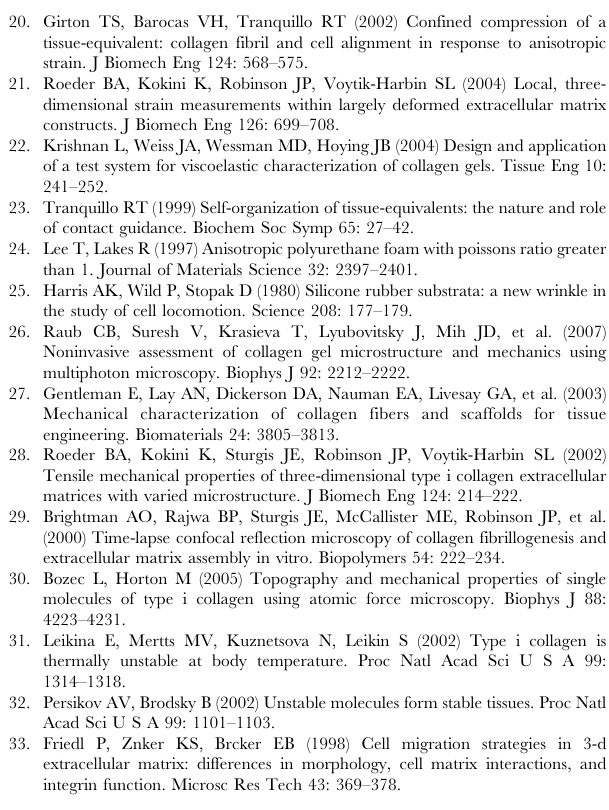
Figure 7. Characterization of the reversibility of alignment and densification in crosslinked and uncrosslinked collagen samples. Response to cycles of deformation for untreated collagen gels (A–E) and gels treated with glutaraldehyde (F–K). (A) Histograms of the fiber orientation as a function of the imposed strain for untreated sample; color at each point corresponds to the relative count of fibers oriented along a specific direction at a given strain e xx . (B) Resulting order parameter for untreated sample. (C–E) Confocal reflectance images of a 1 mg/mL collagen sample cycled 4 times up to 15% stretch and back to 0%, showing the extent of the reversibility at the microstructural level: (C) beginning of 1st stretch cycle; (D) middle of 1st stretch cycle; (E) end of 1st stretch cycle; bars=50 m m. (F) Histograms of the fiber orientation as a function of imposed strain for glutaraldehyde-treated sample; color-coding as in (A). (G) Resulting order parameter and density for glutaraldehyde-treated sample. (H–J) Confocal images of a 1 mg/mL collagen samples with glutaraldehyde, cycled 4 times up to 15% stretch and back to 0%: (H) beginning of 3rd stretch cycle; (I) middle of 3rd stretch cycle; (J) end of 3rd stretch cycle; bars=25 m m. (K) Mesoscopic response to 15% strain cycles for various strain rates at a constant imposed strain amplitude. The bold line corresponds to the strain rate used for all other